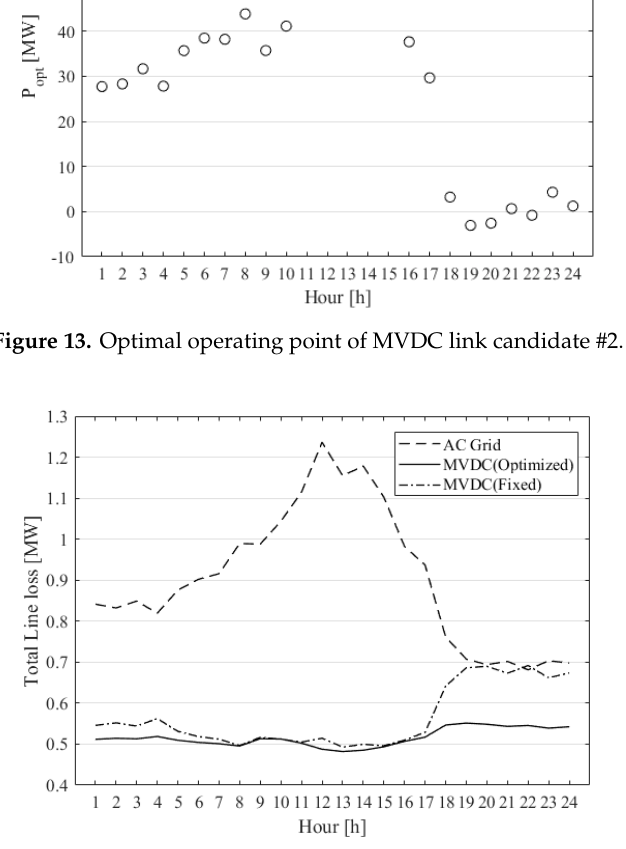
Figure 14. Comparison of total line losses in Area 2.